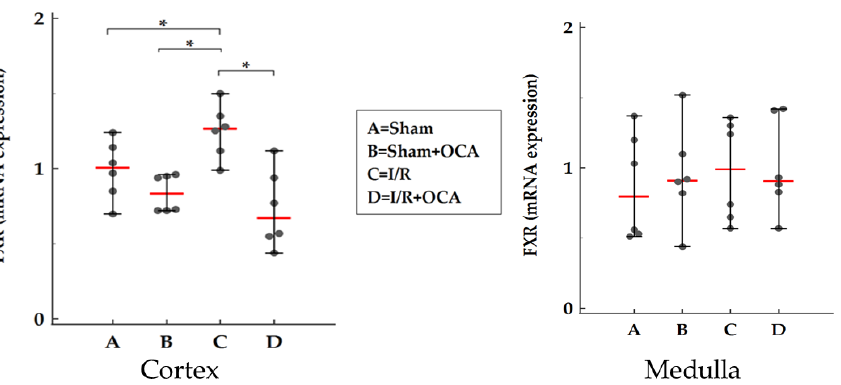
Figure 5. FXR expression in kidney cortex and medulla in rats submitted to partial liver ischemia (60 min) followed by reperfusion (120 min). Animals were orally administered with OCA 10 mg/kg/day in methylcellulose 1% for 5 days ( n = 12) or with vehicle alone ( n = 12). Sham-operated animals were subjected to the same procedure without clamping the vessels. n = 6 rats/group. Results are expressed as median value (red line) ± error bar (1–99 percentiles) (black dot). One-way ANOVA with Tukey–Kramer test; * p < 0.05 versus I/R rats.